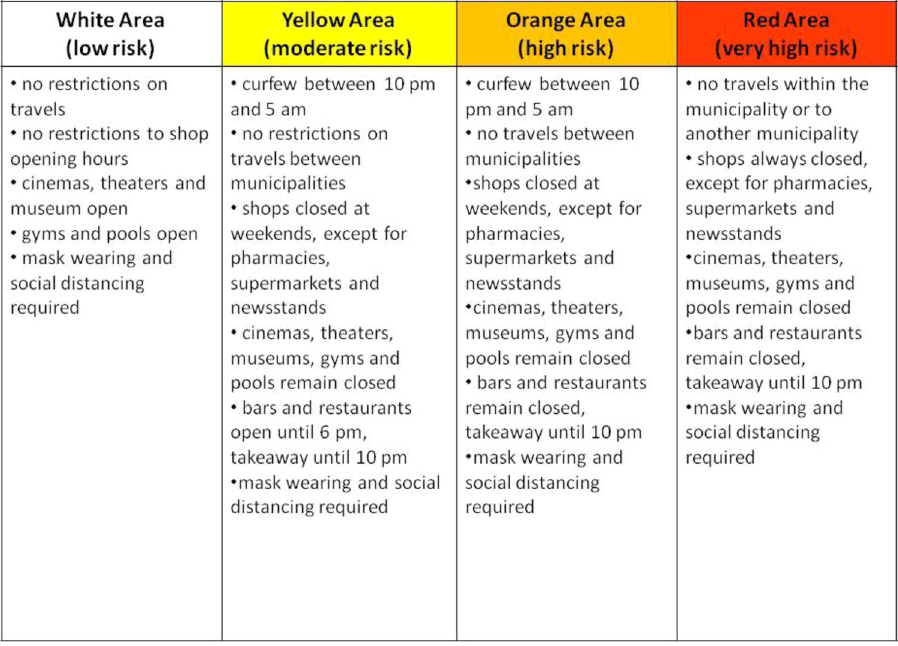
Fig. 4 Levels of risk and corresponding restrictions for each color-coded area as implemented in the second wave of the pandemic (fall/winter 2020) in Italy. Figure by